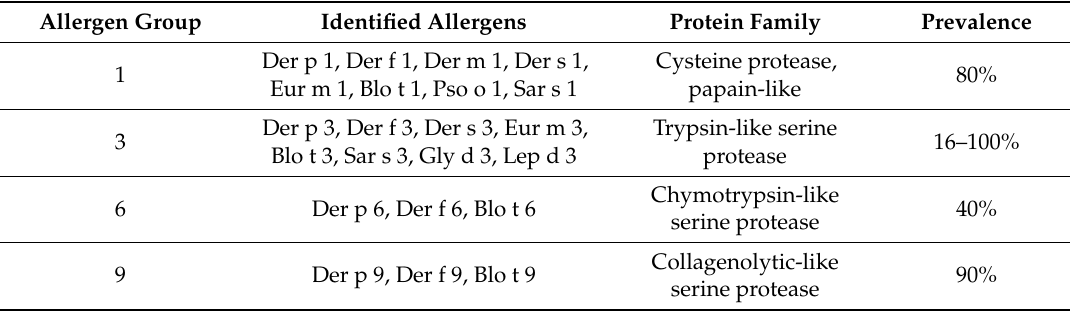
Table 1. Protease allergens in house dust mites. Adapted from Moises A. Calder ó n, et al. [6]. Allergen